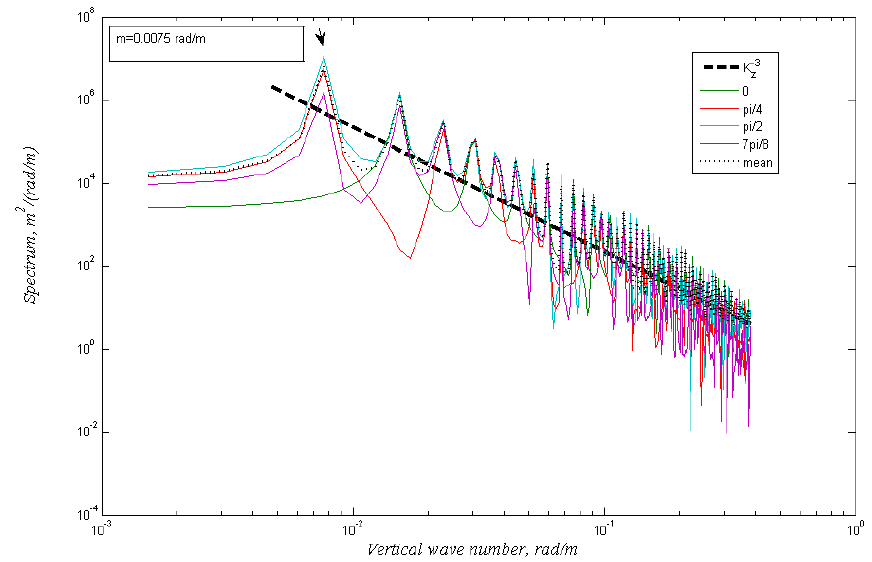
Fig. 7. Vertical wave number spectra of the vertical displacements S E,z (z,x 0 ,t 0 ) calculated for M 0 = 0 . 45 ( M =0.9), m = 0 . 0075rad/m, A = 120m, X = m/k a = 15, x 0 = 0 and for different values of ωt 0 indicated in the upper right corner.